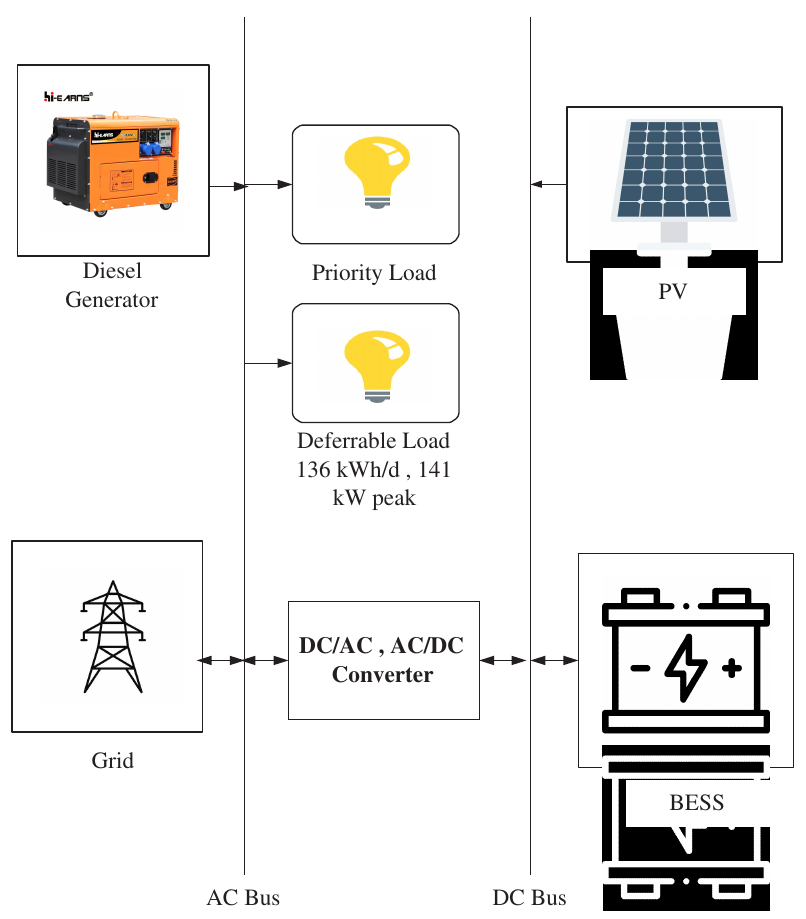
Figure 1. Micro grid model under